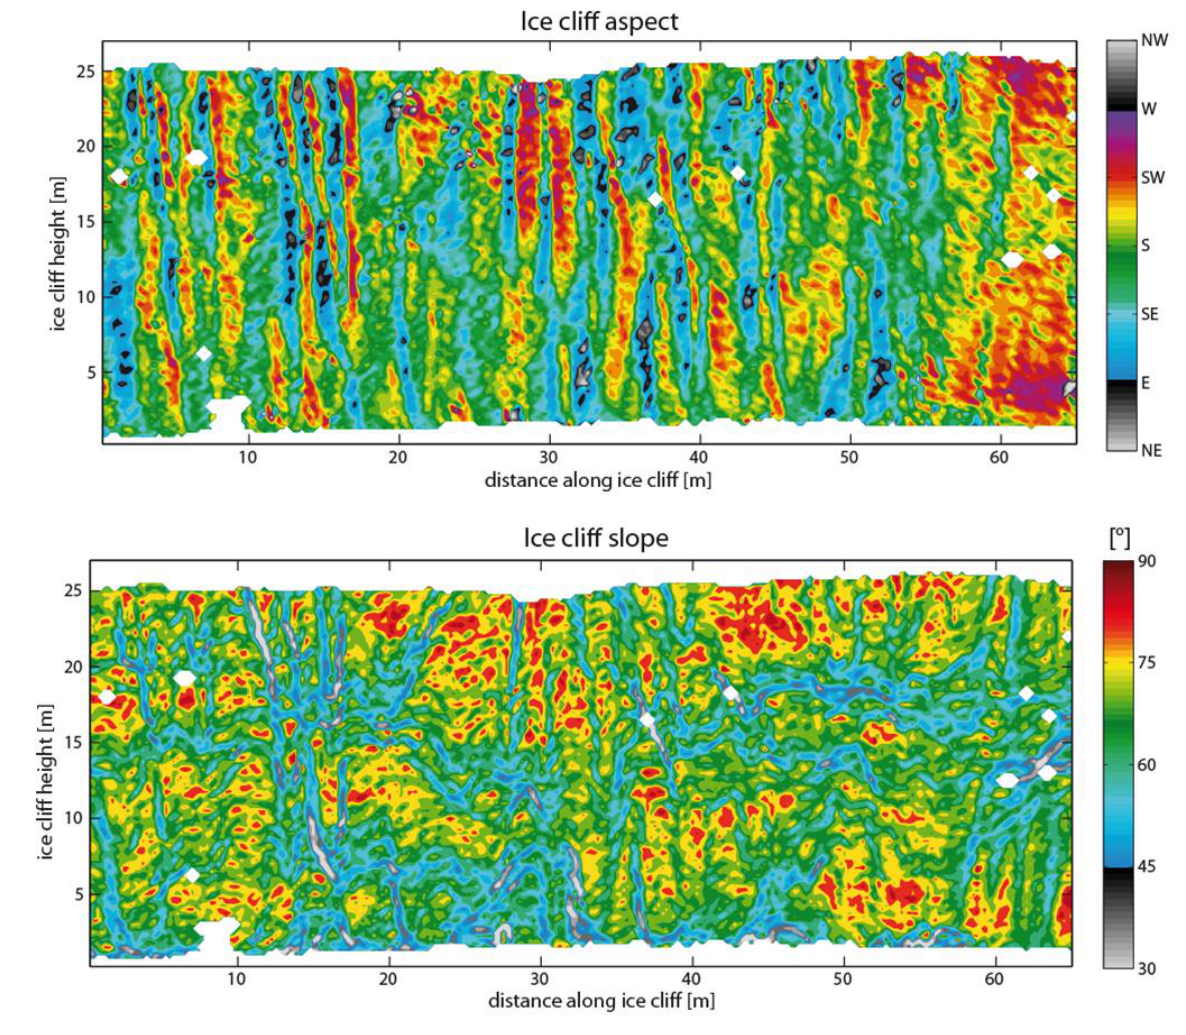
Figure 4: Ice cliff aspect and slope in October 2010. On average the ice cliff faces approximately south (173° from north) and its slope is 66.9° with only minor changes occurring over time. The resolution in width and height is 25 cm.